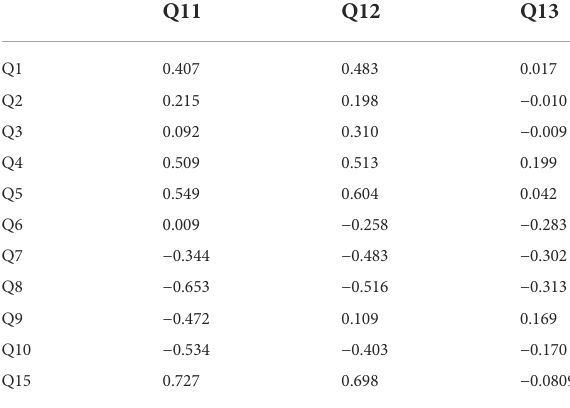
TABLE 2 Pearson ’ s correlation coef fi cients of questionnaire answers among the children.